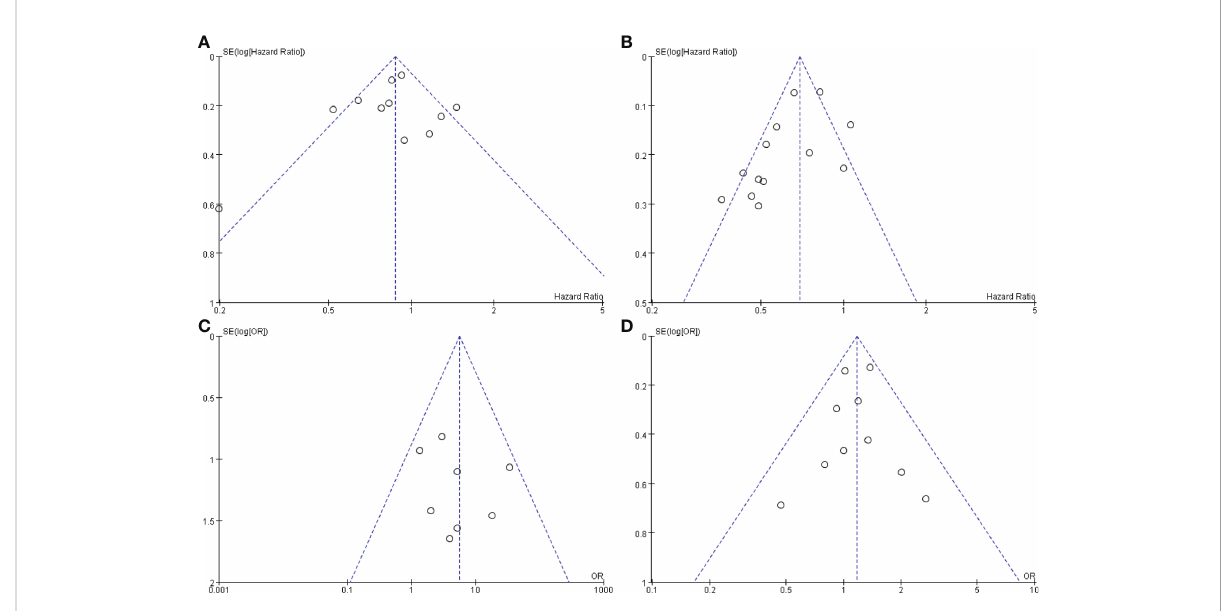
FIGURE 7 Funnel plots based on OS (A) , PFS (B) , CR (C) , and grade ≥ 3 AEs (D) . OS, overall survival; PFS, progression-free survival; CR, complete response; AEs, adverse